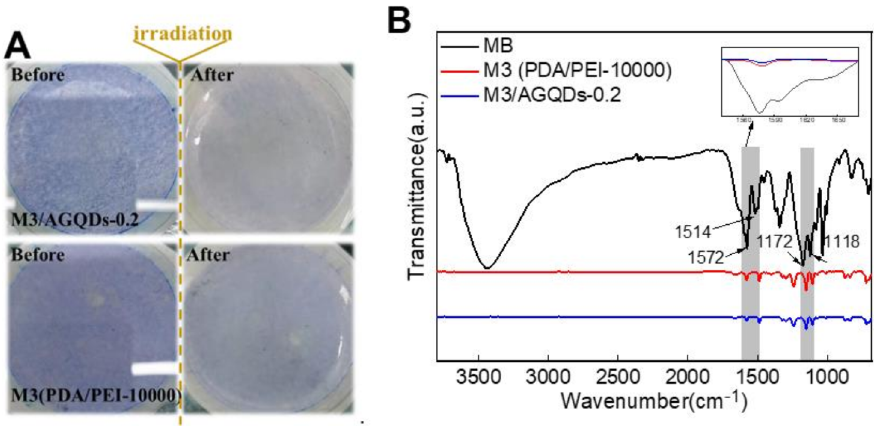
Figure 13. The surface of NF membranes before and after visible light irradiation ( A ) and FT—IR spectrum of methyl blue and NF membranes ( B